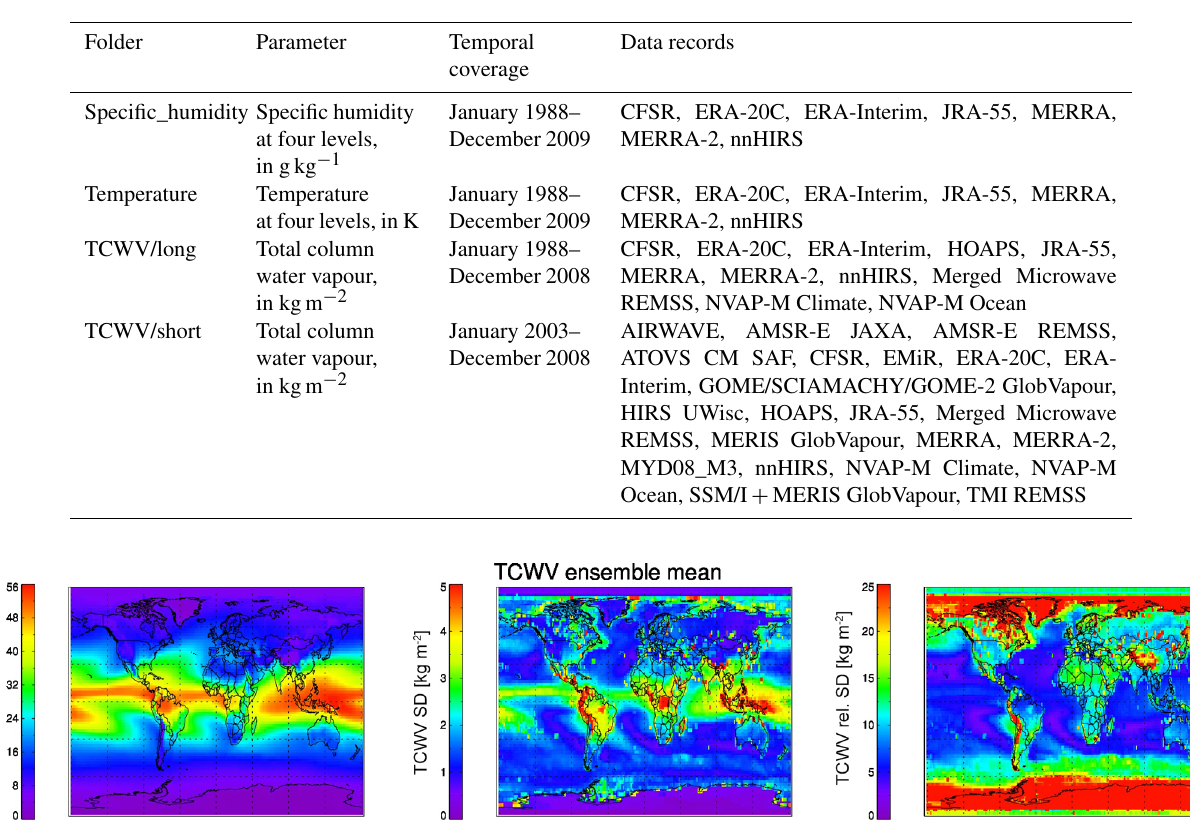
Table 3. Overview of the G-VAP data archive.